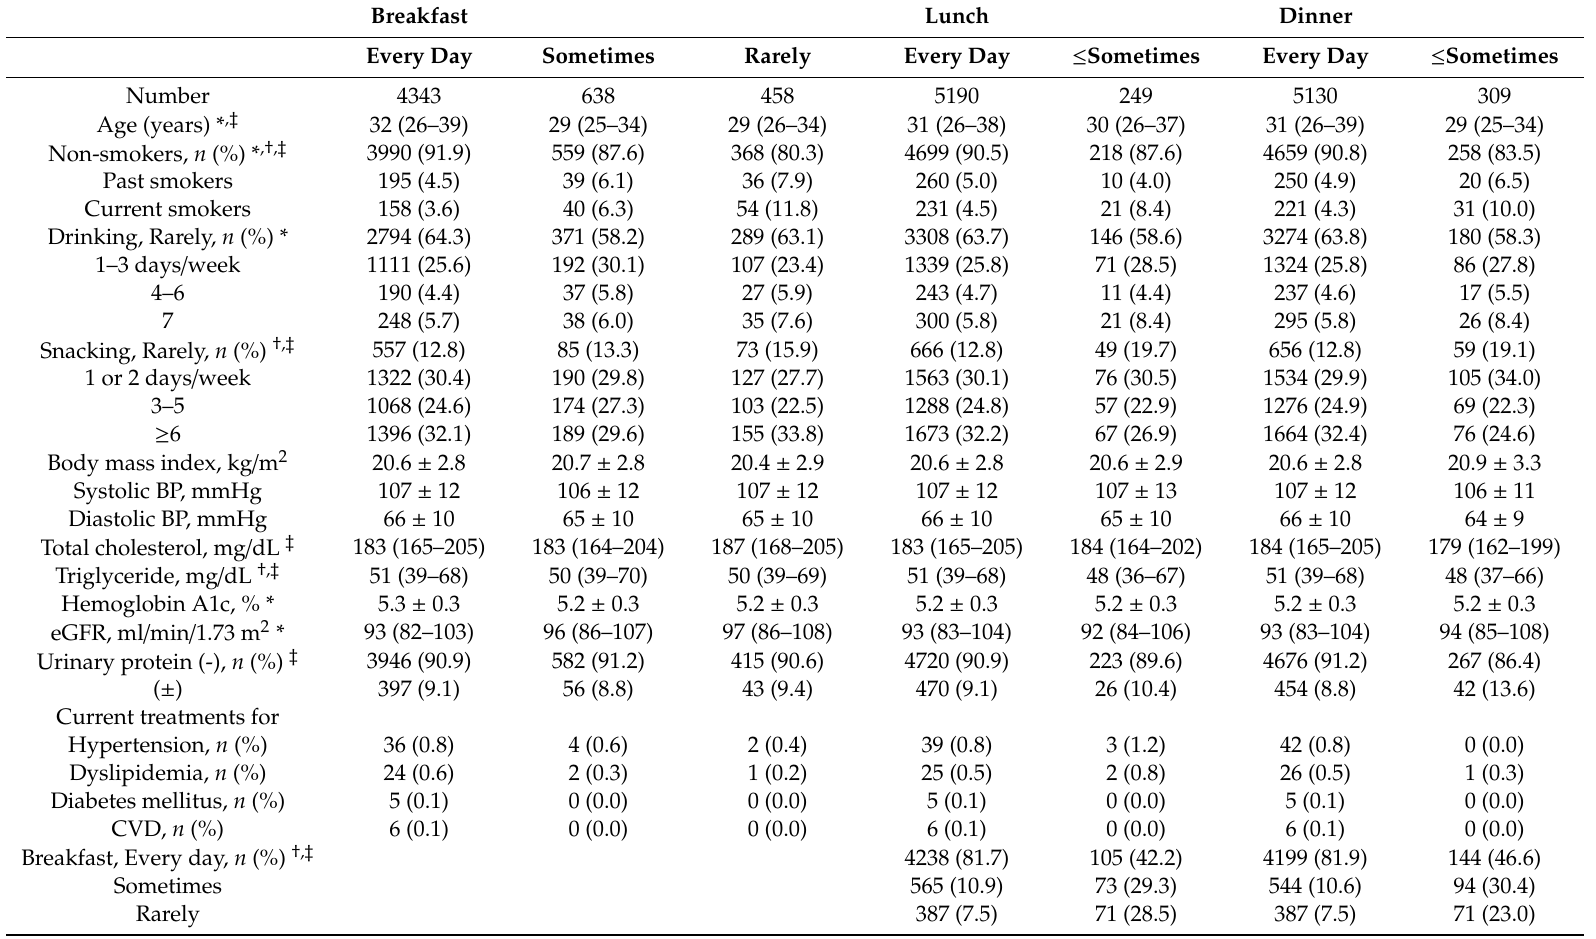
Table 1. Baseline characteristics stratified by the frequency of breakfast, lunch, and dinner in 5439